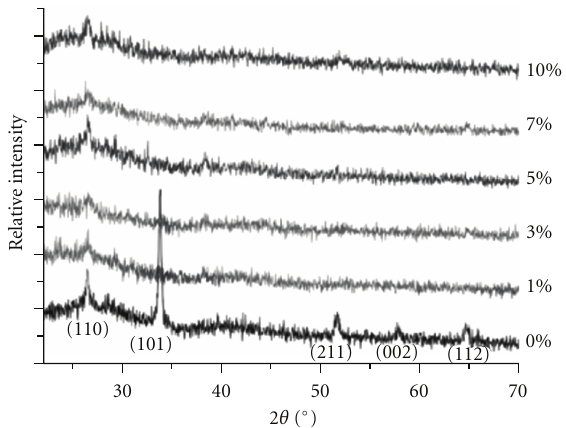
Figure 3: XRD patterns of SnO 2 films deposited at di ff erent oxygen